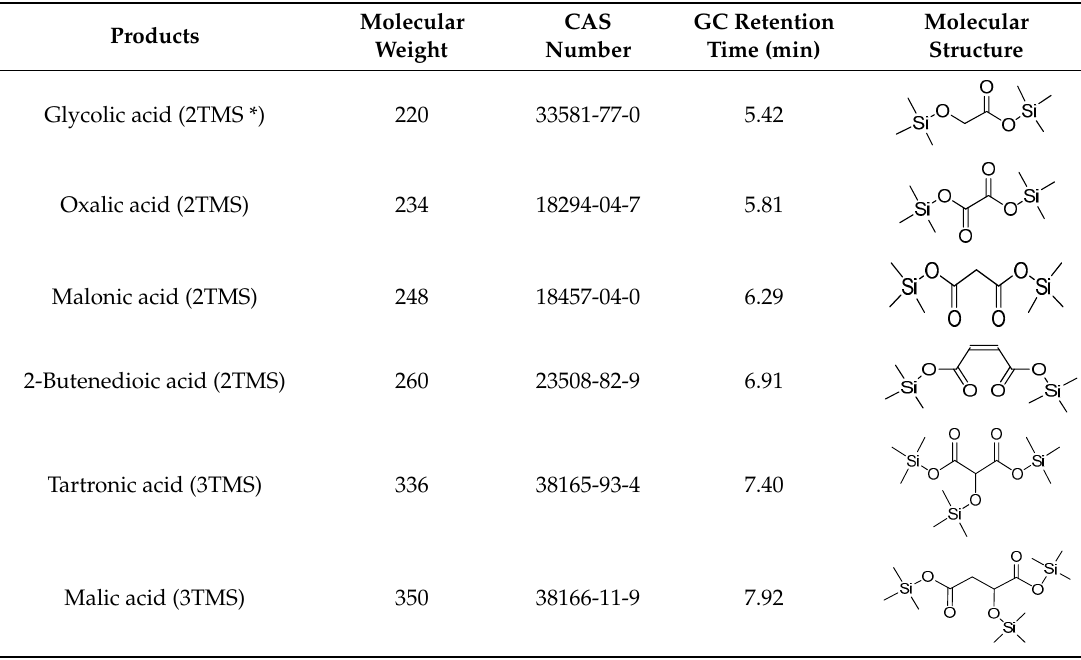
Table 5. Degradation products of BP detected by GC/MS.